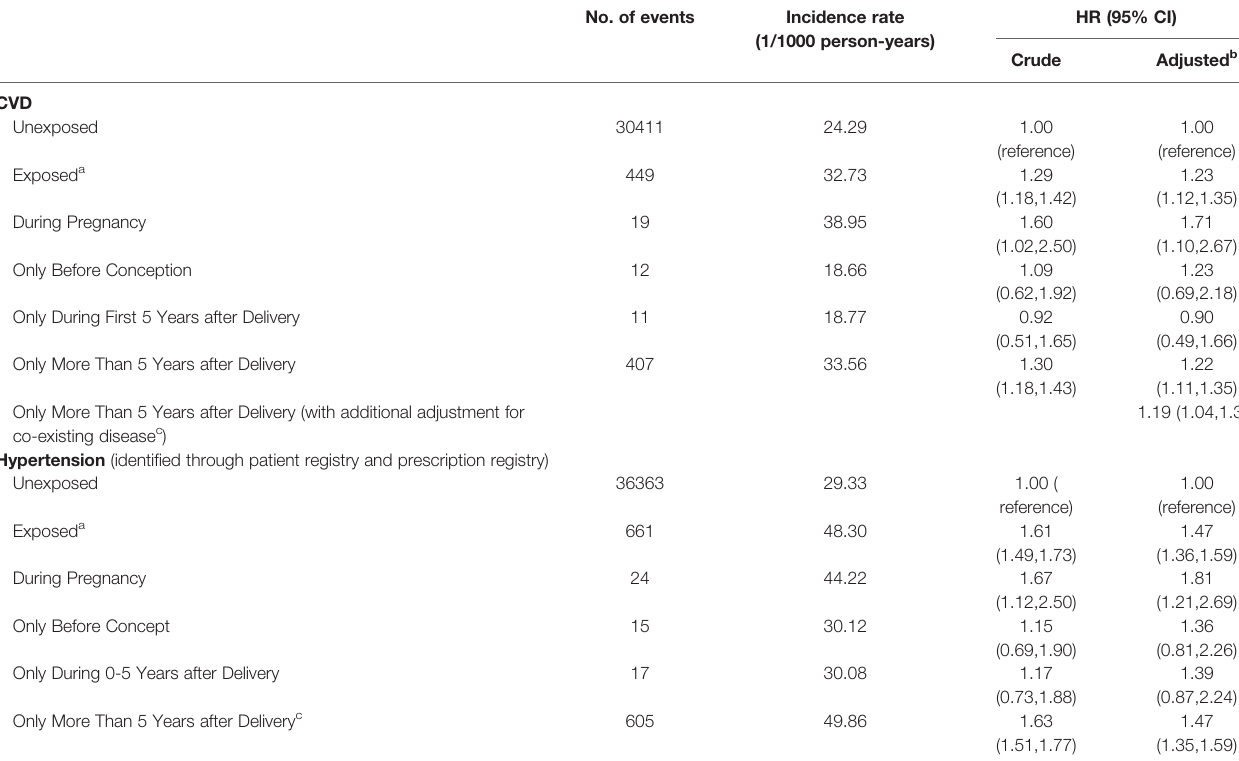
TABLE 3 | Hazard ratios and 95% con fi dence intervals for offspring ’ s CVD according to maternal hypothyroidism in different exposure windows.